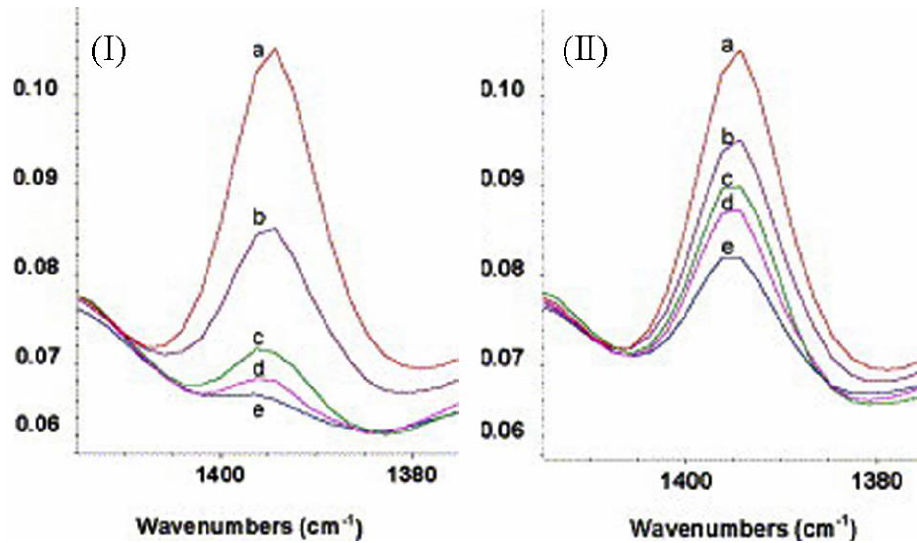
Figure 23. DRIFT spectra of 4-TBN on silica gel (a) at zero time after adsorption; (b) after 1 day; (c) after 3 days; (d) after 6 days; (e) after 8 days at room temperature and ( I ) water-saturated atmosphere, and ( II ) vacuum conditions. Reprinted with permission from [92]. Copyright Elsevier, 2005.